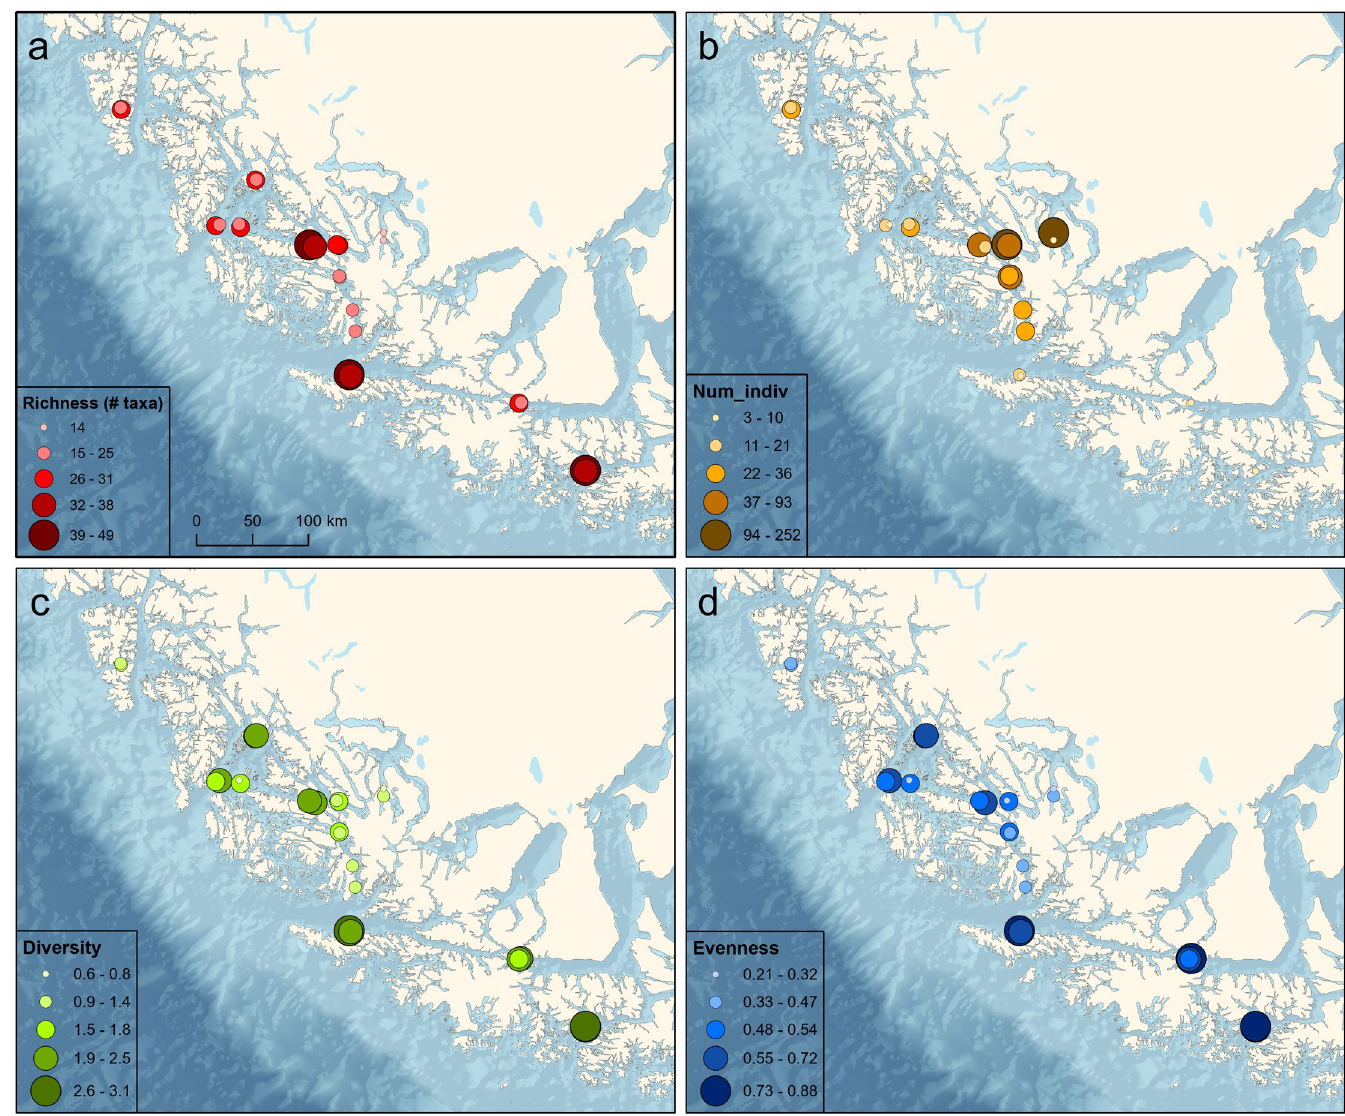
Fig 4. Benthic community characteristics among sampling locations. (A) Species richness, (B) number of individuals m -2 , (C) Shannon-Weaver Diversity Index, (D) Pielou’s evenness.